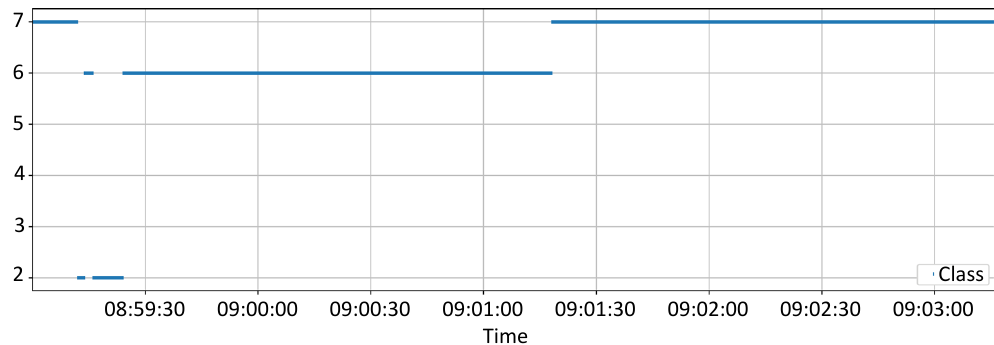
Fig. 6. Temporal distribution of the classes in a sample video (30 September 2019, video from hour